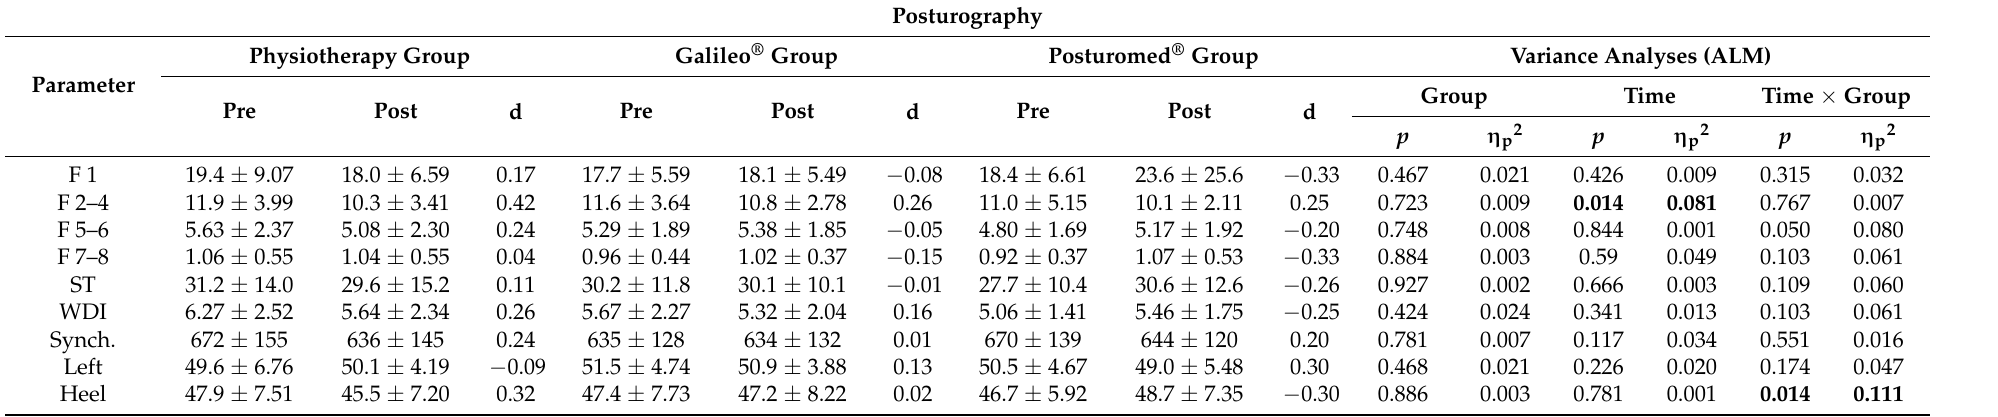
Table 3. Descriptive group comparison (mean ± SD) using